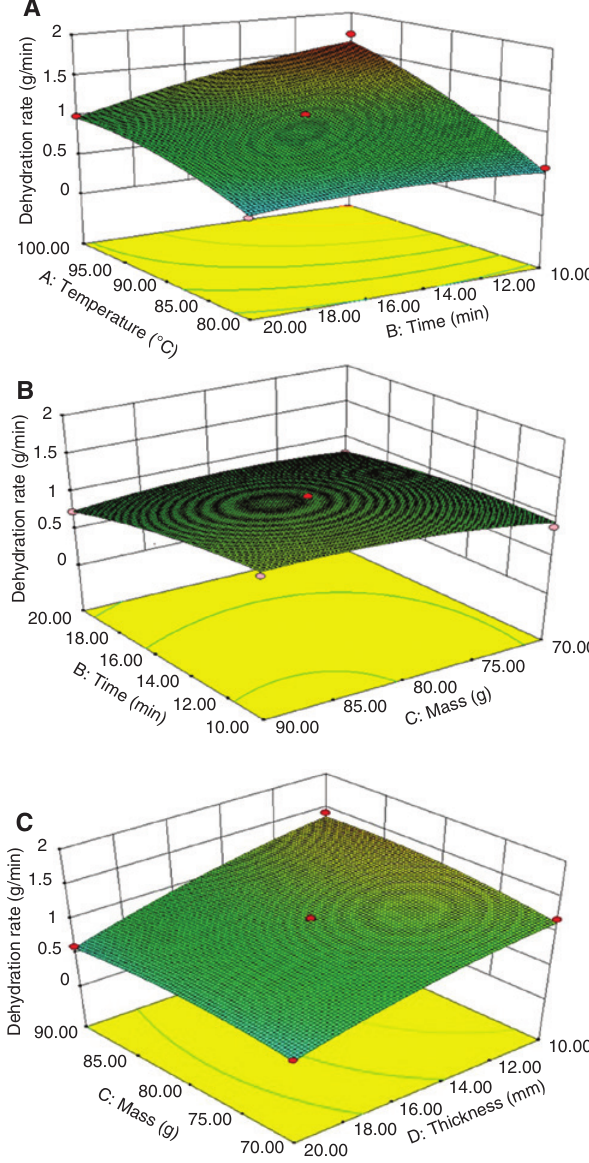
Figure 8: Three-dimensional response surface plot of dehydration rate: effects of the statistically significant interaction factors on dehydration rate of zinc oxide leach